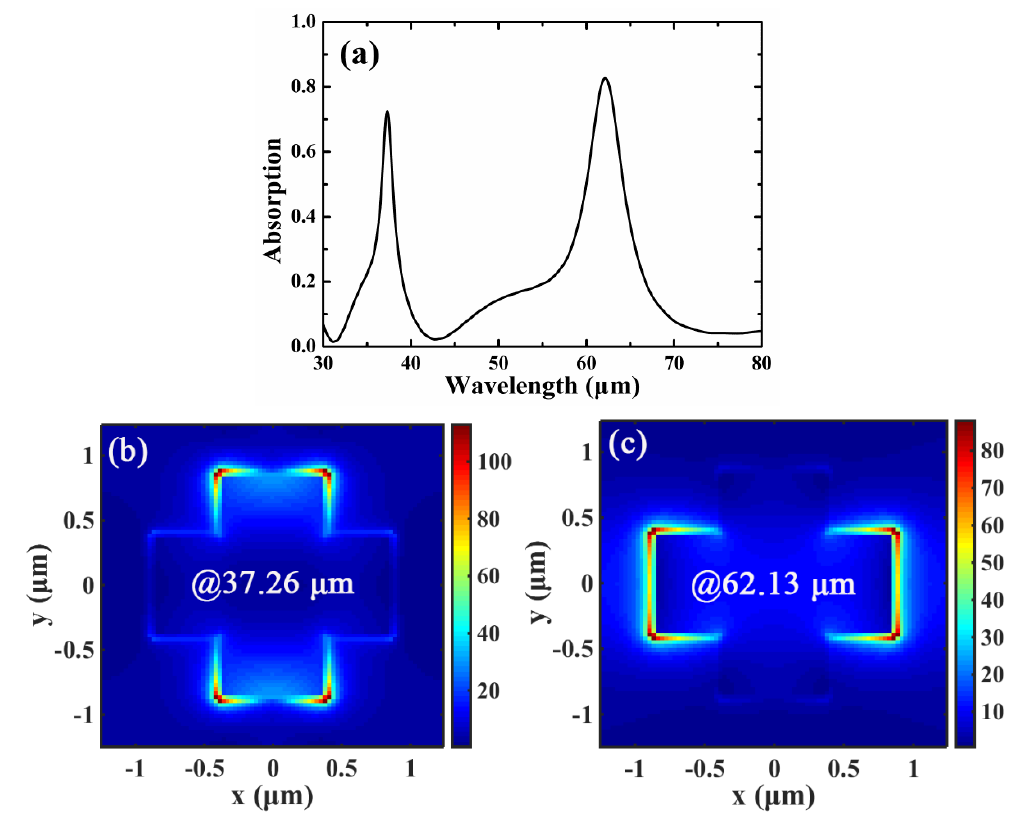
Figure 3. ( a ) Absorption response of the cross-shaped graphene arrays. ( b ) and ( c ) are the normalized electric-field distributions of the cross-arm in the xy plane for absorption peaks of 37.26 μ m and 62.13 μ m, respectively.